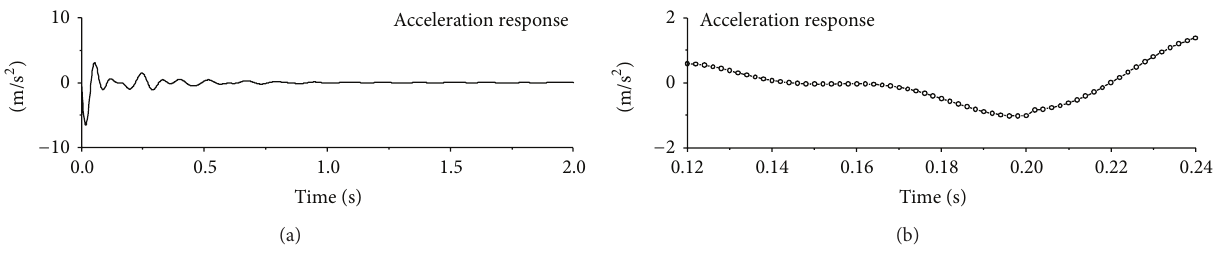
Figure 4: Signal discontinuity due to sudden damage (impulse